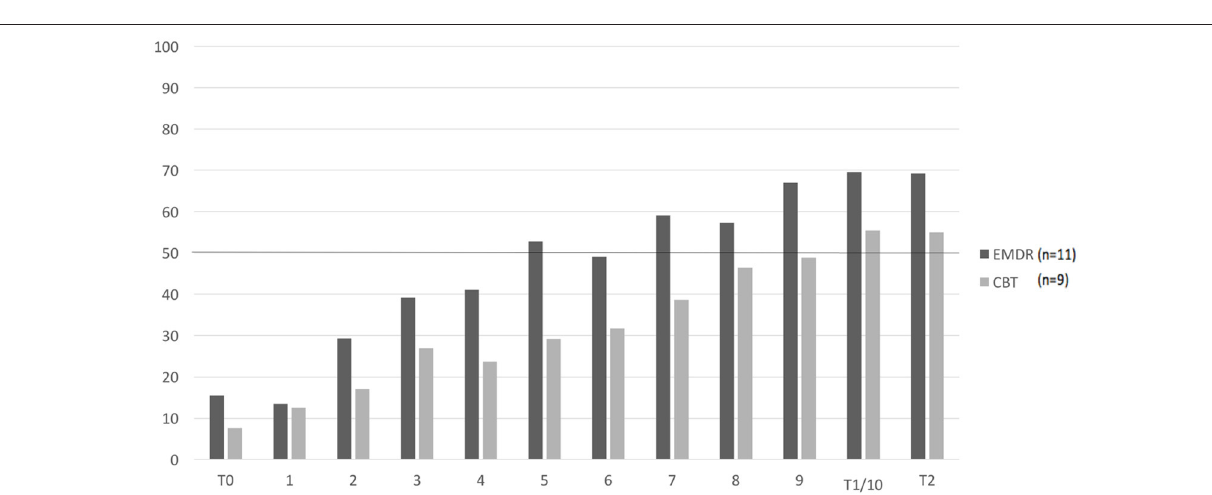
FIGURE 3 | Mean scores on the CPAB per condition over the course of treatment ( n post-treatment, T3: months follow-up. 1–10: weekly sessions. 0–100%: credibility of core belief. Missing values were imputed with last observation carried